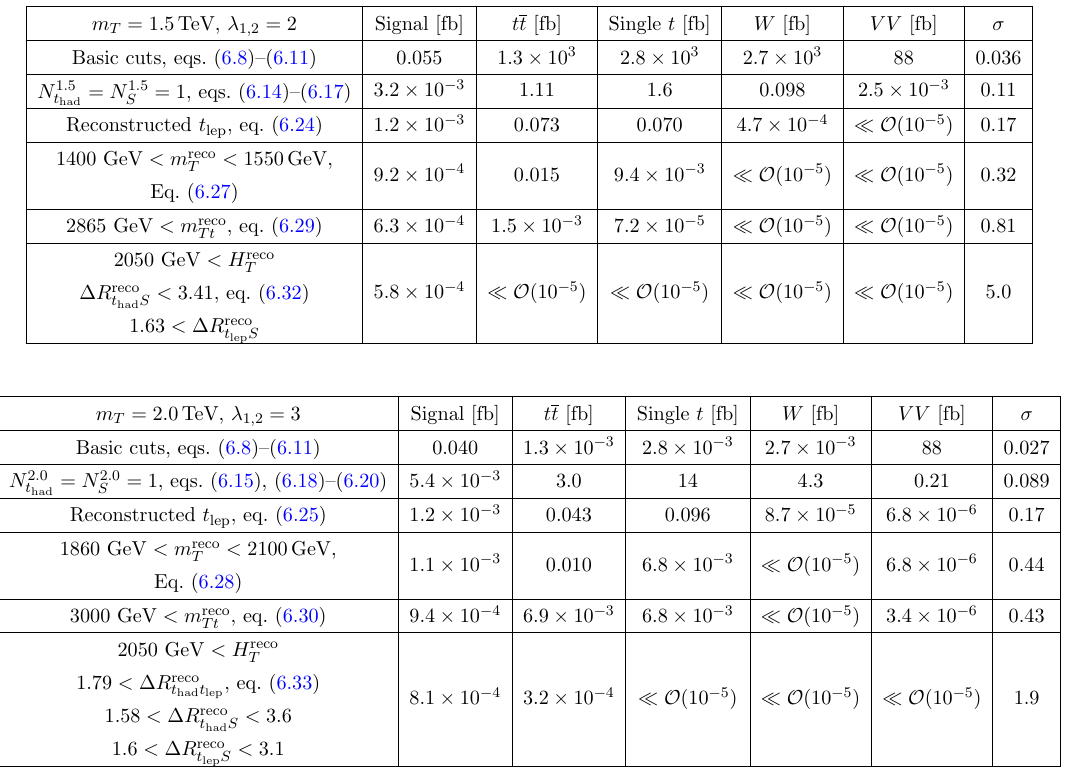
Table 5 . Cumulative cut-(cid:13)ow tables showing the SM background and signal cross sections at two benchmark parameter points (top) m T = 1 : 5 TeV and (cid:21) 1 ; 2 = 2 and (bottom) m T = 2 : 0 TeV and (cid:21) 1 ; 2 = 3 where we (cid:12)xed other parameters to m S = 110 GeV, sin (cid:18) L = 0. Signi(cid:12)cances ( (cid:27) ) are calculated based on the likelihood-ratio method de(cid:12)ned in eq. (6.34) for given luminosity of 3 ab (cid:0) 1